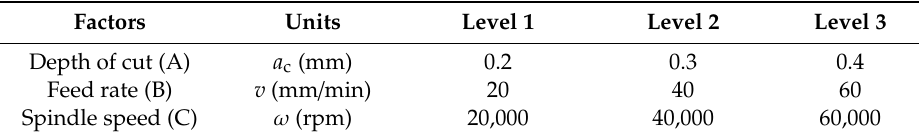
Figure 7. Temperature measurements in the bone grinding experiment using temperature sensors of three thermocouples (marked as TC1, TC2, and TC3).